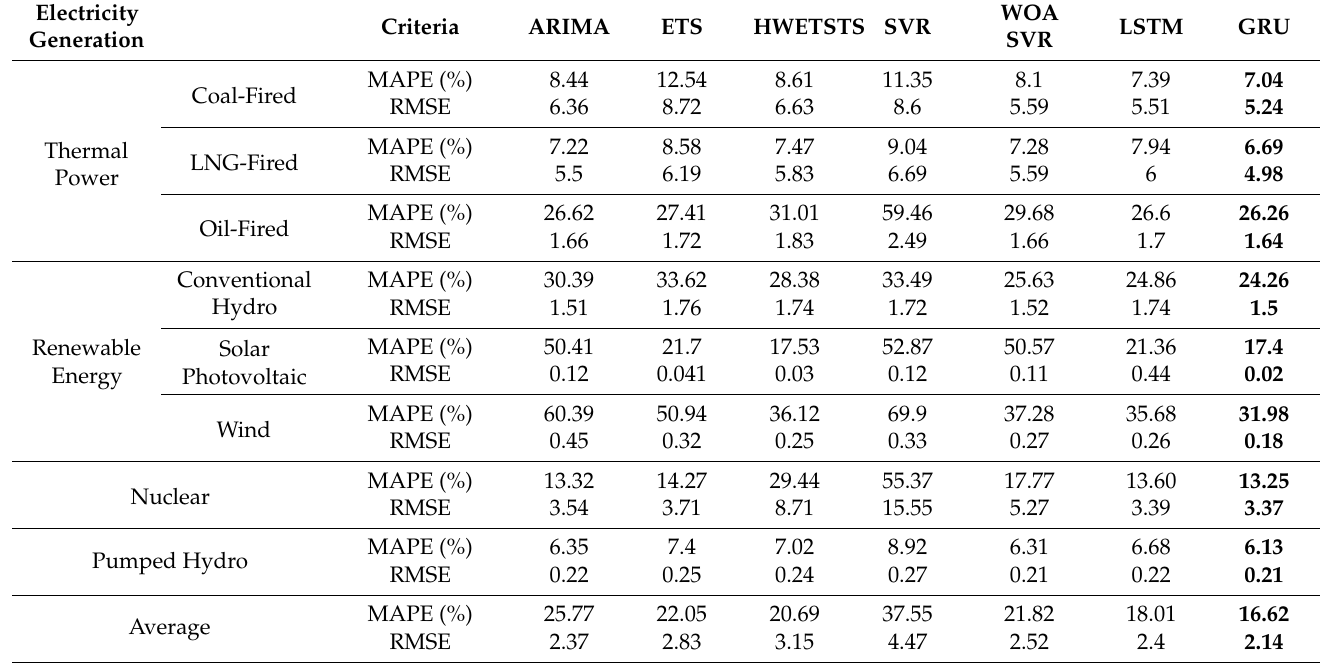
Table 4. Power generation predictions obtained using different methods for the period from 1 January